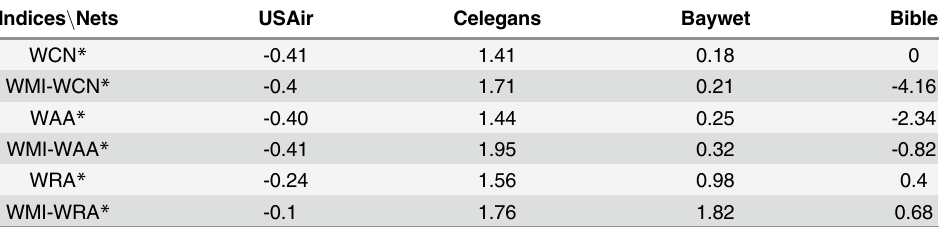
Table 2. Optimal values of parameter α subject to the highest Precision values in four